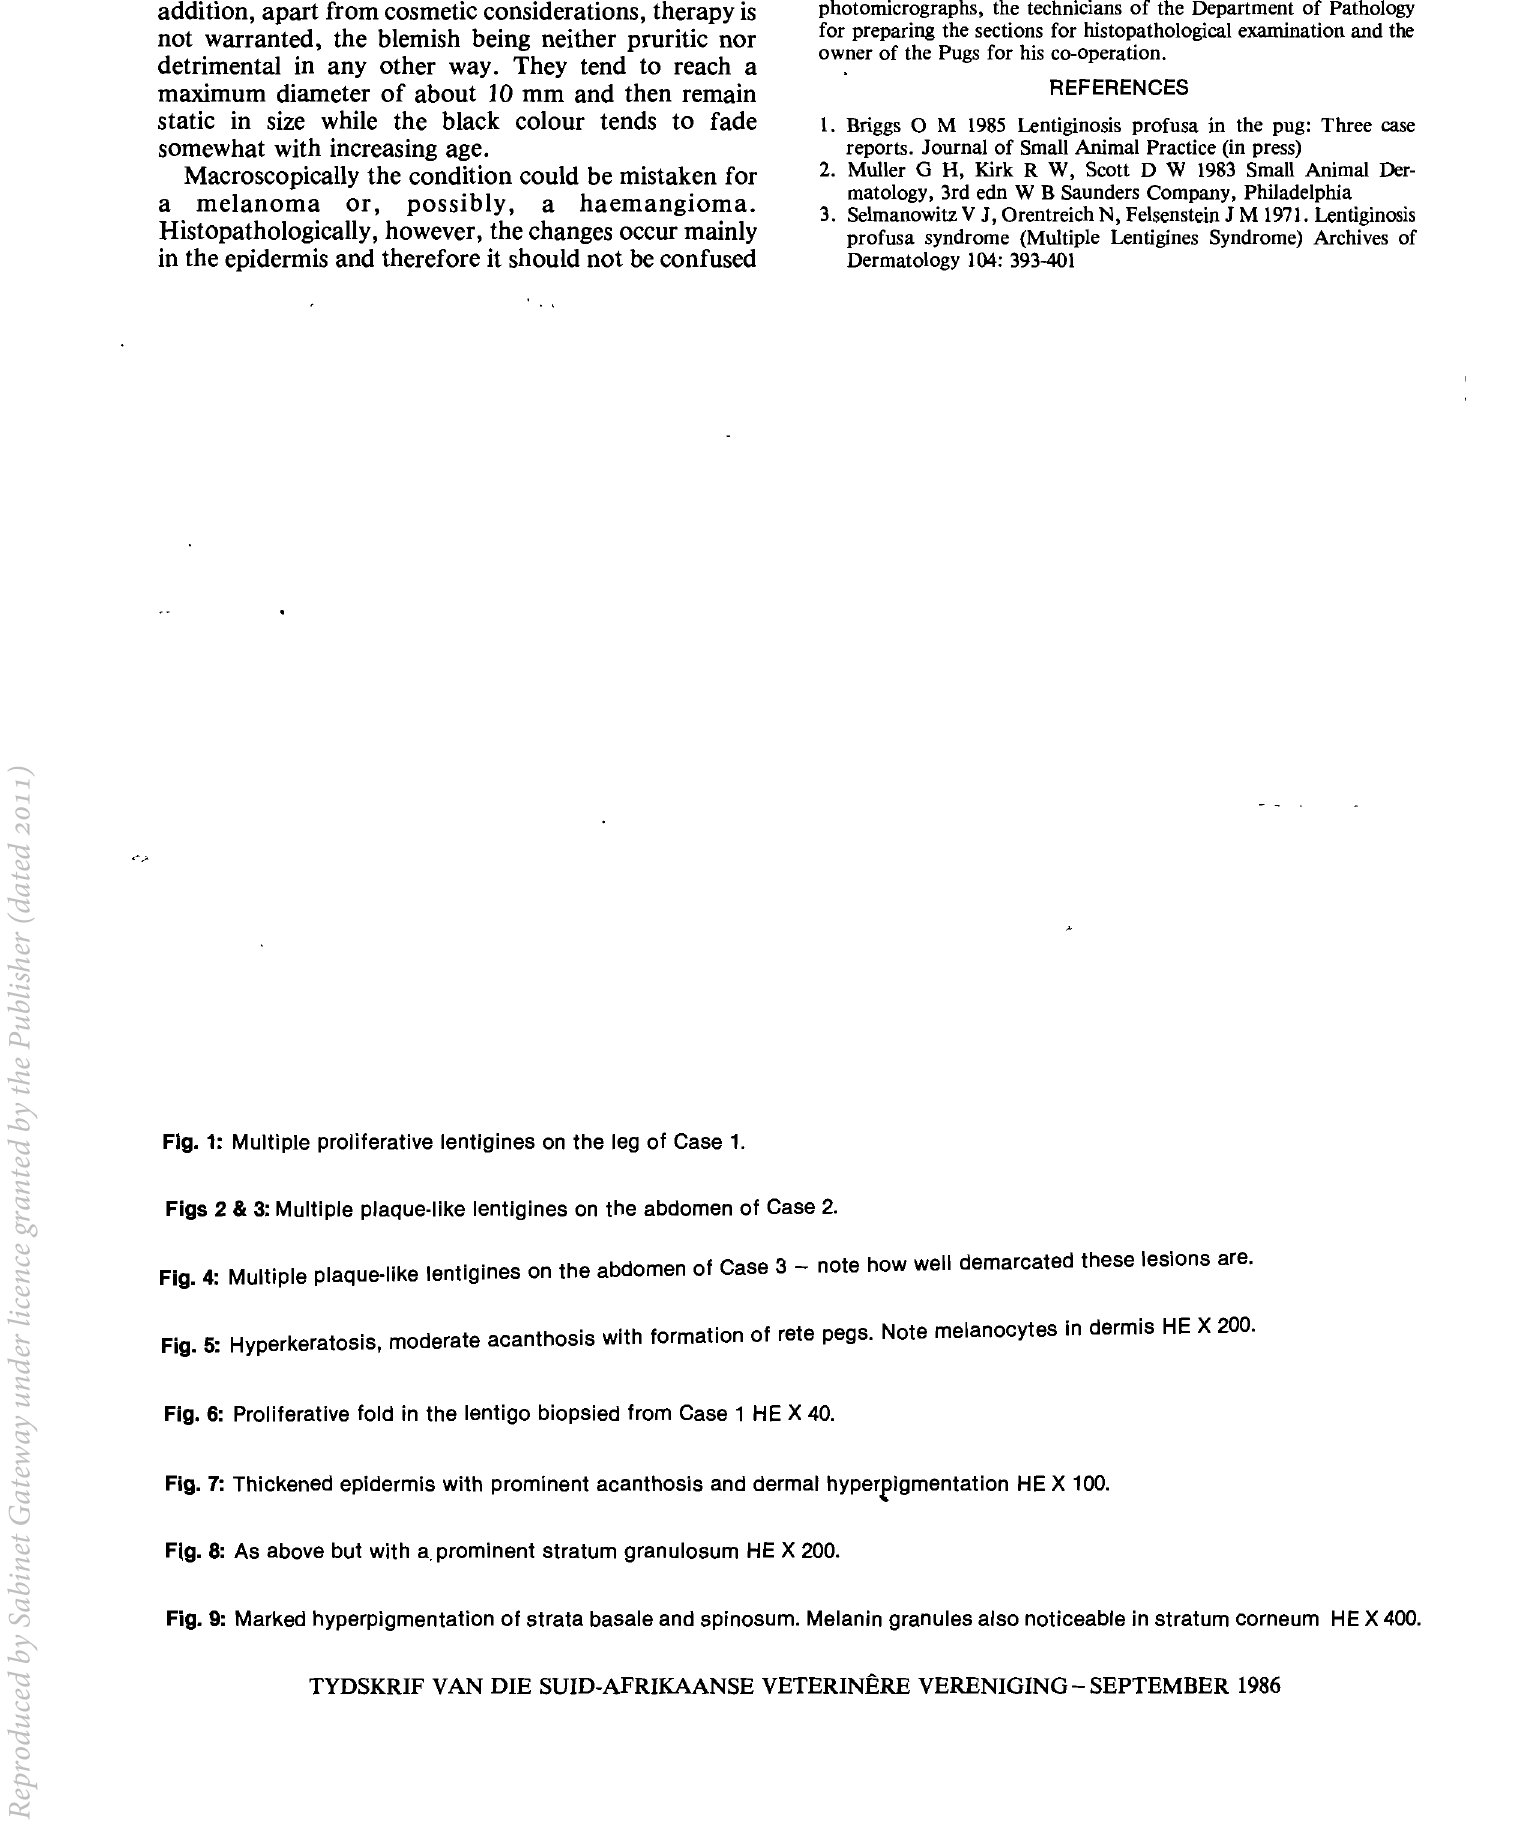
Fig. 6: Proliferative fold in the lentigo biopsied from Case 1 HE X 40. Fig. 7: Thickened epidermis with prominent acanthosis and dermal hyperpigmentation HE X 100. Fig. 8: As above but with a. prominent stratum granulosum HE X 200. Fig. 9: Marked hyperpigmentation of strata basale and spinosum. Melanin granules also noticeable in stratum corneum HE X 400. TYDSKRIF VAN DIE SUID-AFRIKAANSE VETERINERE VERENIGING-SEPTEMBER